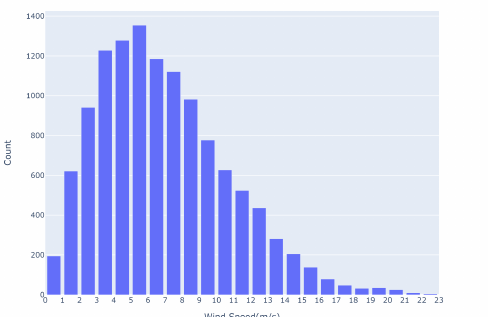
Figure 4. Distribution of wind speed forecast data.